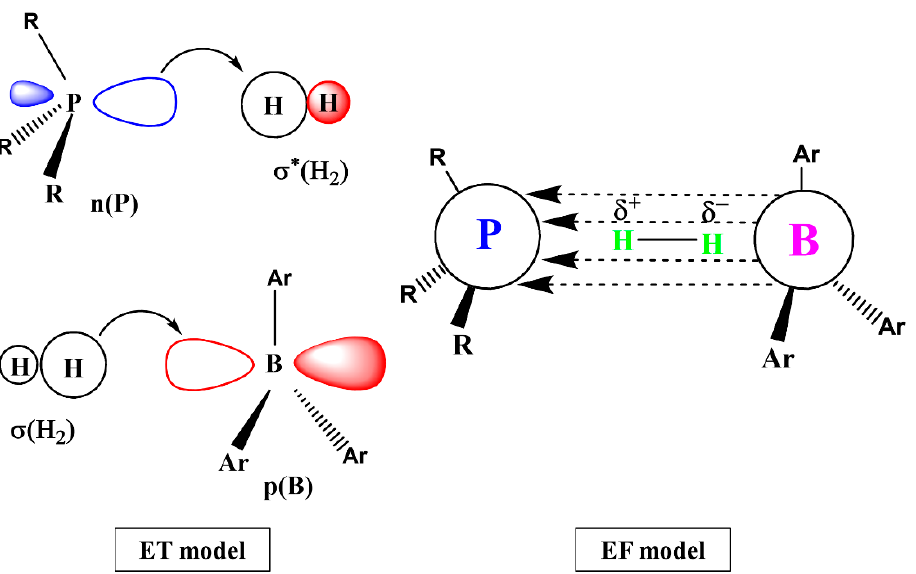
Figure 2. Schematic figure of the electron transfer (ET) and electric field (EF) model-based interpretations of FLP-mediated H 2 activation.